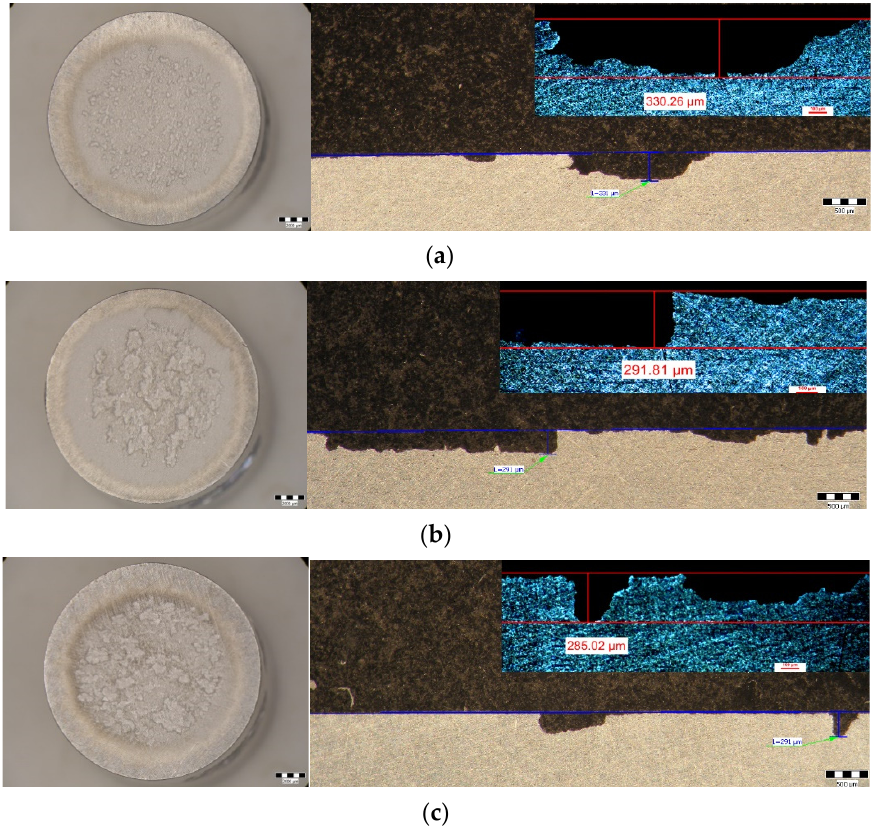
Figure 11. Appearance of macrostructural surfaces (left front section, parallel to the eroded surface, right in cross section, background image under an optical microscope, detail image under a stere- omicroscope) subjected to cavitation erosion from alloy 5083, poured followed by hardening solu- tion 350 ℃ /maintenance 100 min/cooling air quietly and subjected to artificial aging at 180 ℃ and different maintenance times: ( a ) 1 h; ( b ) 12 h; ( c ) 24 h .